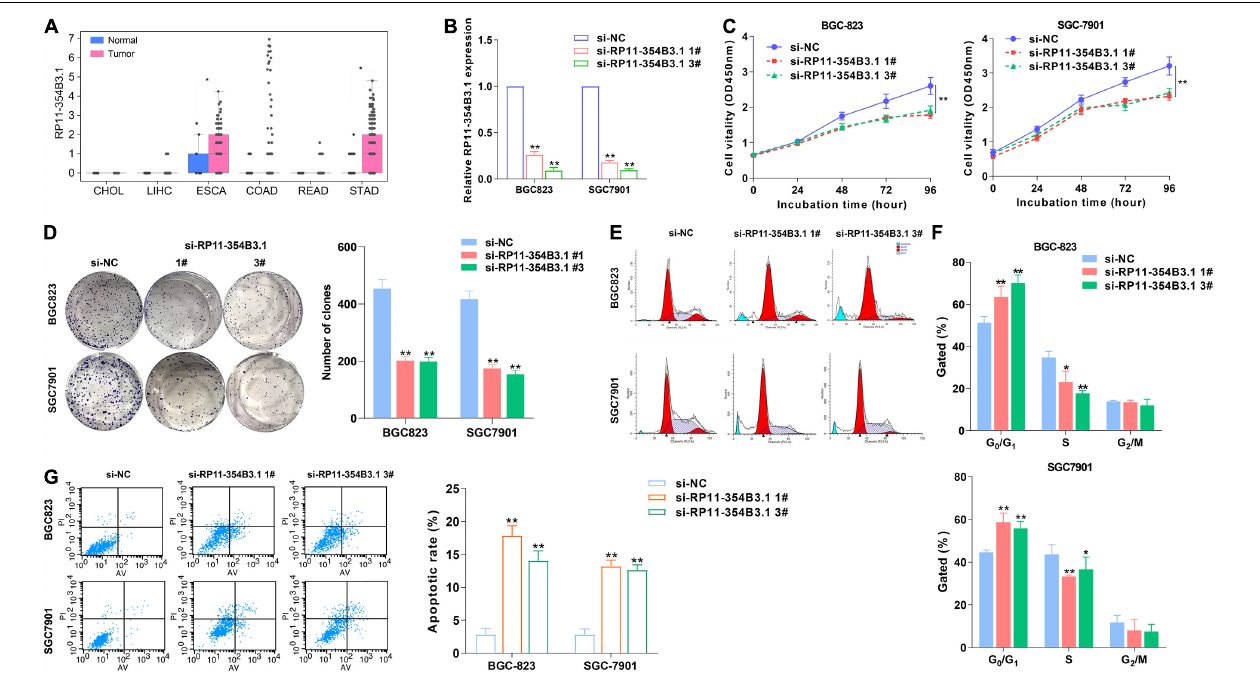
FIGURE 2 | Higher RP11-354B3.1 expression levels and its functional role in gastric cancer cells. (A) Data mining of the fold change of RP11-354B3.1 in TCGA datasets (LIHC, CHOL, ESCA, READ, COAD, and STAD). (B) qRT-PCR analysis of RP11-354B3.1 expression in gastric cancer cells depleted of RP11-354B3.1. (C) Growth curves show the proliferation ability of RP11-354B3.1 -depleted gastric cancer cells. (D) Colony formation assays were used to evaluate the colony formation capacity of RP11-354B3.1-depleted gastric cancer cells. (E,F) FACS analysis of the effect of RP11-354B3.1 down-regulation on cell cycle progression in BGC823 and SGC7901 cells. (G) FACS analysis of the effect of RP11-354B3.1 down-regulation on cell apoptosis in BGC823 and SGC7901 cells. All experiments were performed in three independent replicates. * P < 0.05; ** P < 0.01.